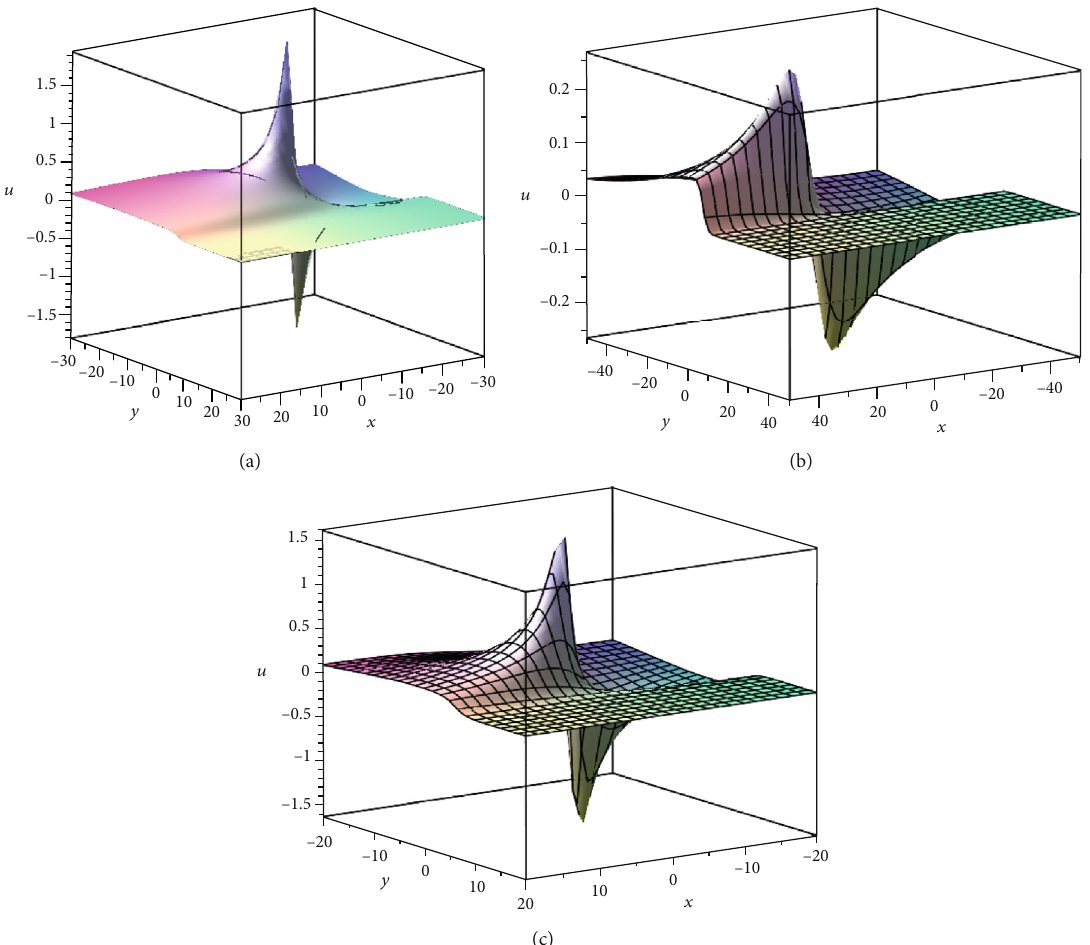
= 1 , p = 1 , a = 1 , a = 1 , a = 1 , and δ = 1 ; 2 3 7 5 6 1